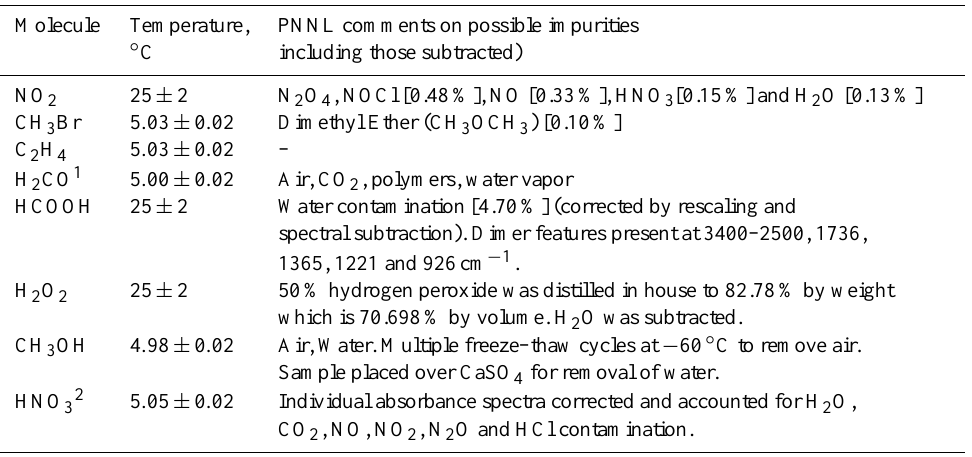
Table 1. Characteristics of PNNL data on considered molecules. Molecule